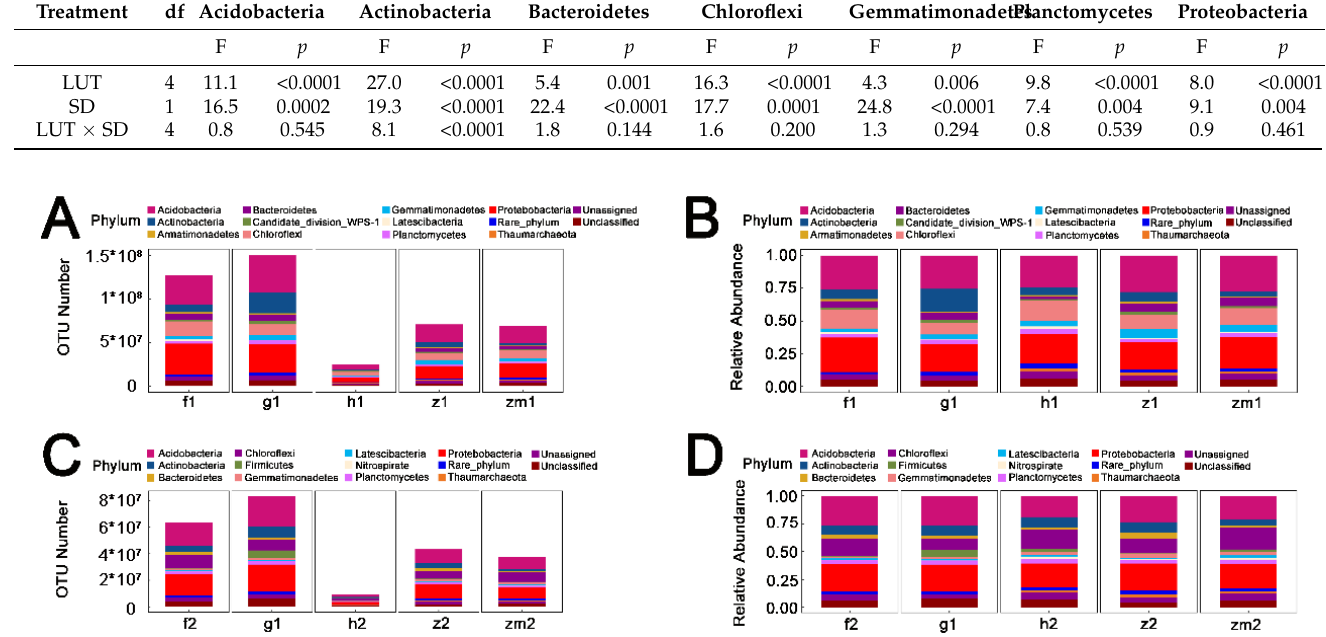
Figure 3. Absolute abundances (( A , C ) represent 0 – 20 cm and 20 – 40 cm soil depth, respectively, 16S rRNA gene copy numbers per gram of soil) and relative abundances (( B , D ) represent 0 – 20 cm soil depth and 20 – 40 cm soil depth, respectively, %) of the major bacterial phyla in all soil samples. g1: grass land at 0 – 20 cm; g2: grass land at 20 – 40 cm; f1: secondary forest land at 0 – 20 cm; f2: secondary forest land at 20 – 40 cm; z1: Zanthoxylum planispinum land at 0 – 20 cm; z2: Zanthoxylum planispinum land at 20 – 40 cm; h1: Hylocereus spp. land at 0 – 20 cm; h2: Hylocereus spp. land at 20 – 40 cm; zm1: Zea mays land at 0 – 20 cm; zm2: Zea mays land at 0 – 20 cm.